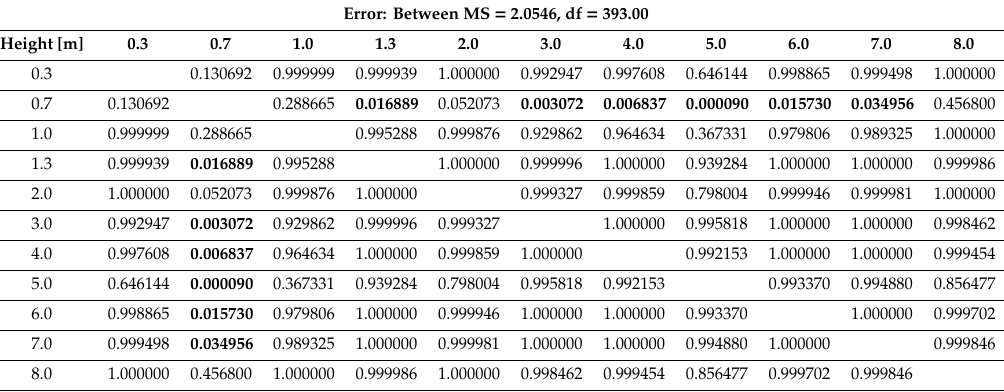
Table A4. Results of one-way ANOVA post hoc Tukey HSD test for CRP data. Error: Between MS = 2.0546, df =